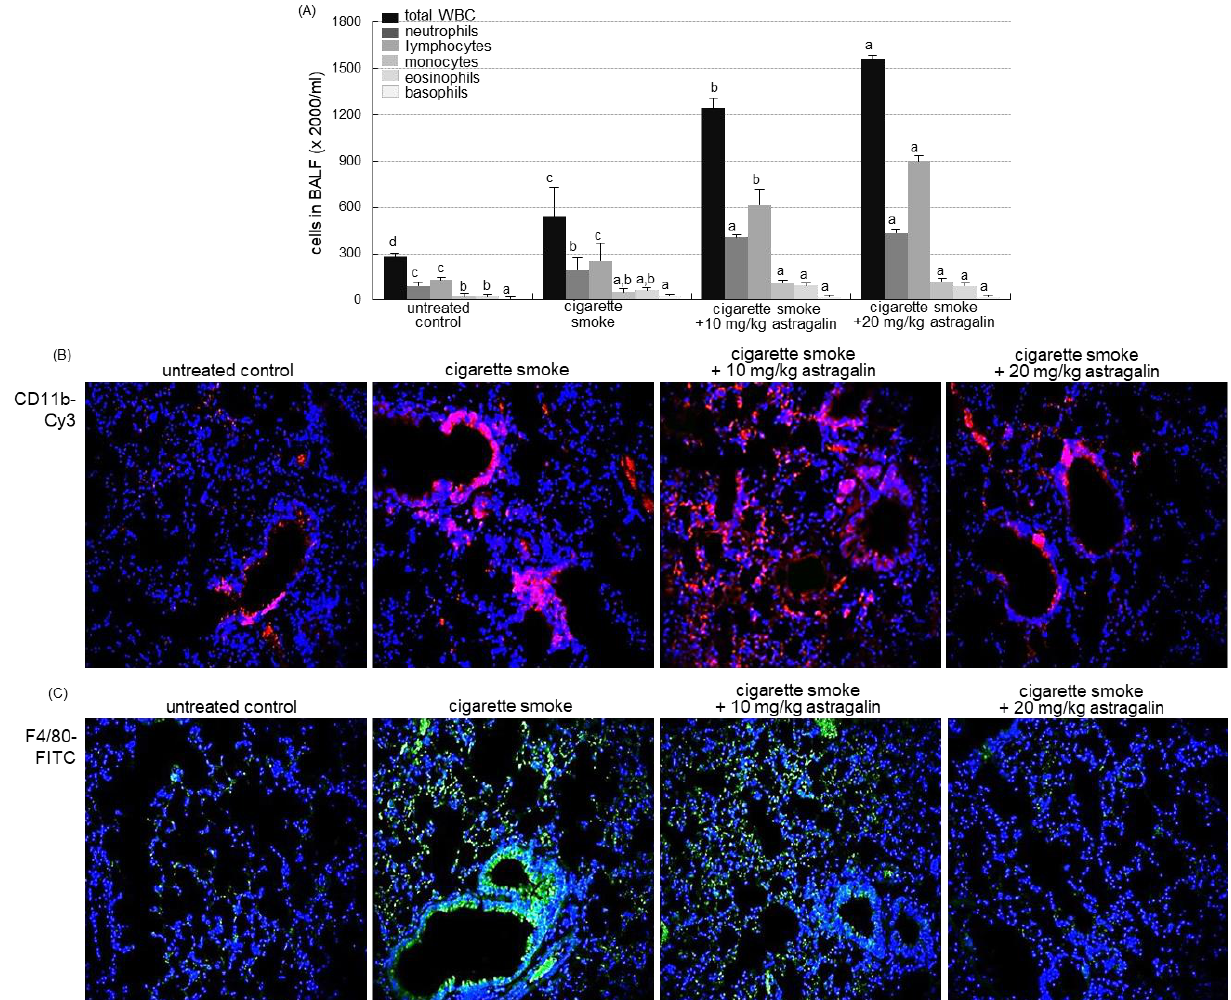
Figure 3. Contents of inflammatory cells in the bronchoalveolar lavage fluid (BALF, ( A )) and infiltration of inflammatory cells ( B ) in the lungs of mice exposed to cigarette smoke. Mice were orally administrated with 10 or 20 mg/kg astragalin and exposed to cigarette smoke. Cells in BALF were counted using a Hemavet HV950 multispecies hematologic analyzer ( A ). Values in bar graphs (same achromatic colored) not sharing the same lower case alphabet letter indicate a significant difference at p < 0.05. For the measurement of levels of CD11b and F4/80 in mouse airways exposed to cigarette smoke, the CD11b was visualized with Cy3-red staining ( B ), and the F4/80 localization was identified as FITC-green staining ( C ). Nuclear staining was done with 4 ′ ,6-diamidino-2-phenylindole (blue). Each photograph is representative of four mice. Magnification: 200-fold.